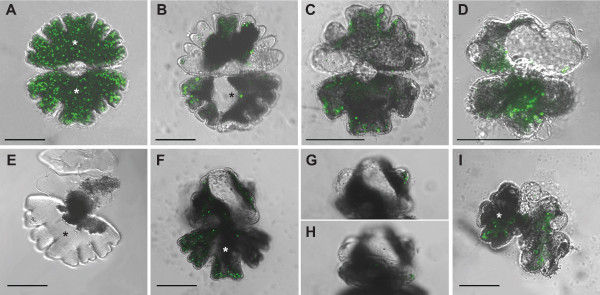
Phenotypes of Micrasterias denticulata cells transiently overexpressing MdEXP2-GFP observed by confocal fluorescence microscopy. Merged transmission light and GFP fluorescence single optical sections (B-I) or projection (A). Initial semicells not formed under MdEXP2-GFP overexpression marked by asterisk. (A) Undivided MdEXP2-GFP overexpressing cell. (B-I) Phenotypes of M. denticulata cells transiently overexpressing MdEXP2-GFP arranged according to phenotype severity. (B) Cell line 11. Upper semicell formed after the first cell division, exhibiting stimulated lobe elongation. The lobes are stretched and rounded instead of flattened at their tips. (C-E) Elongation growth is reduced, lateral lobes are fused. (C) Cell line 6. Lower semicell formed after the second, upper semicell after the third cell division. (D) Cell line 7. Lower semicell formed after the first, upper semicell after the second cell division. (E) Cell line 18. Upper semicell resulting from the first cell division, after which the cell died. (F-I) Cell line 13. Loss of growth polarity and planarity upon cell division. (G, H) Other focal sections of (F) showing that there are three growth planes instead of one. (I) Semicells fused upon the second cell division. Scale bar = 50 μm.